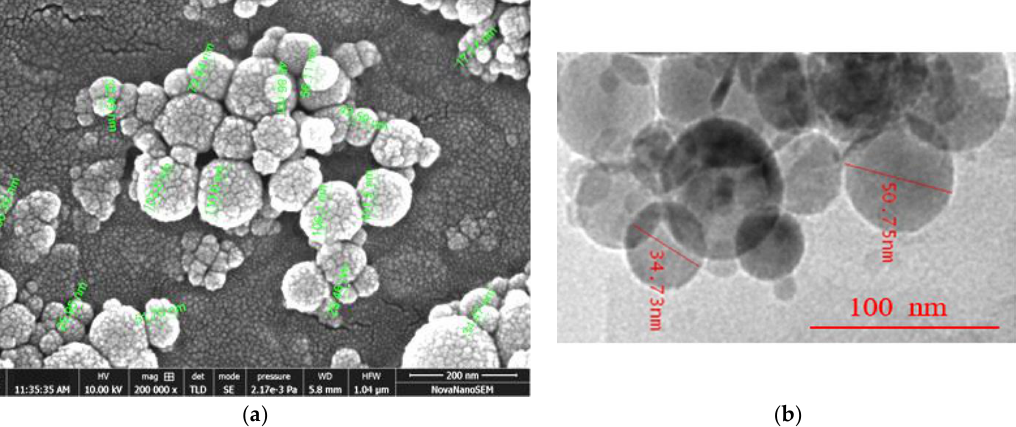
Figure 1. ( a ). SEM image of Al 2 O 3 - TiO 2 /water hybrid nanofluid; ( b ). TEM image of Al 2 O 3 - TiO 2 /water hybrid nanofluid.